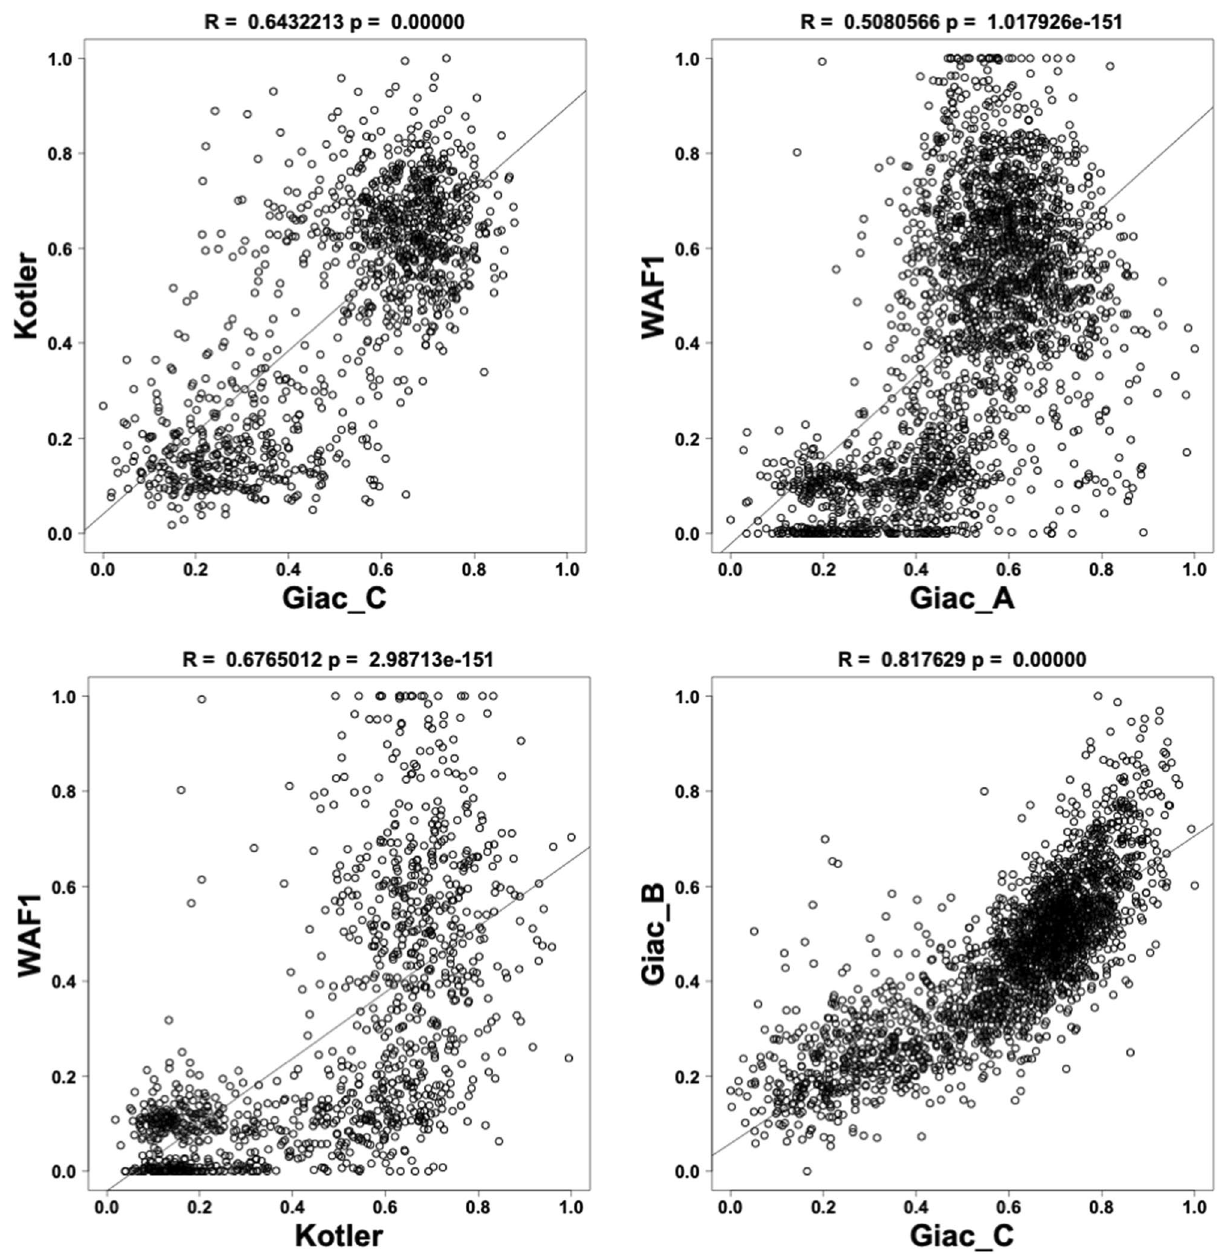
Figure 3. Binary correlation analysis between the various read outs of TP53 loss of activity. Overall Pearson R correlation coefficients and p values are shown at the top of each figure. Data for other read-outs are shown in Supplementary Fig.